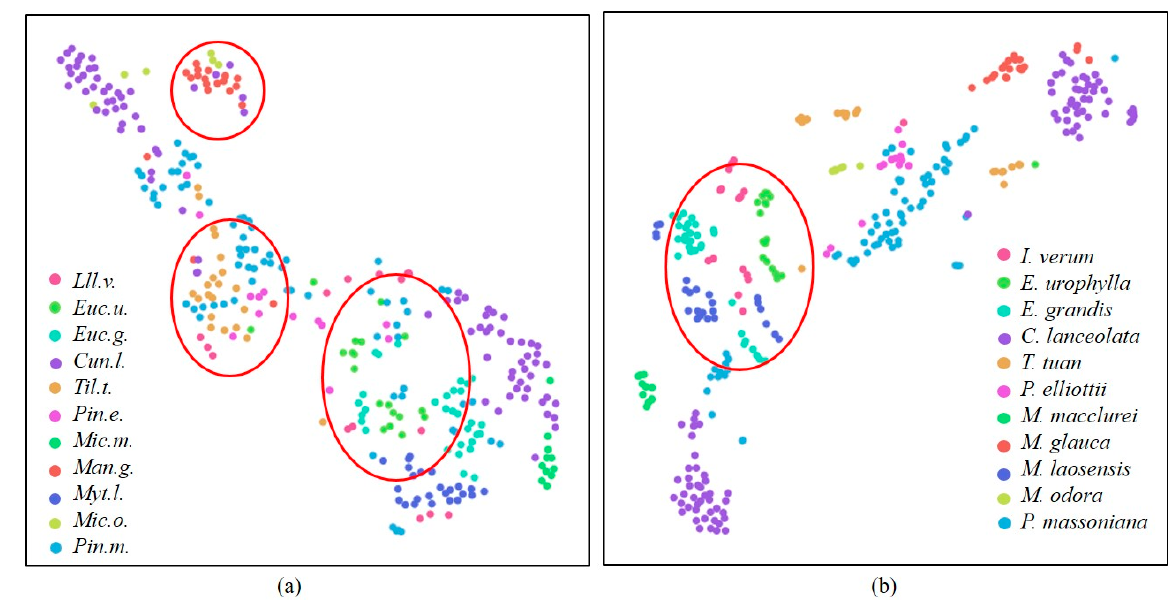
Figure 16. Separability of features: ( a ) the separability of summarized features used in traditional methods. ( b ) The separability of comprehensive features used in the FSP method.